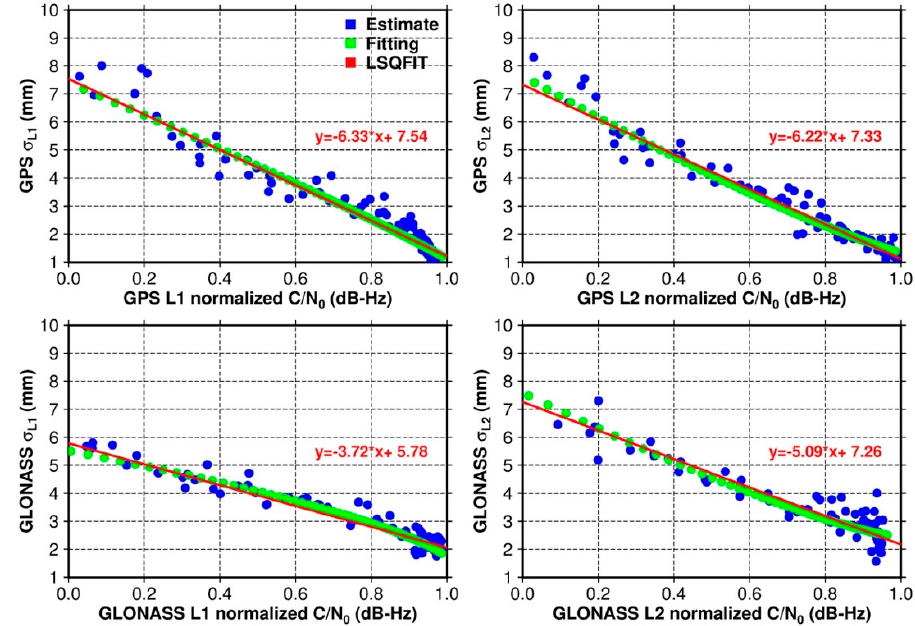
Figure 11. The functional relationship between normalized SNR data and the precision of phase